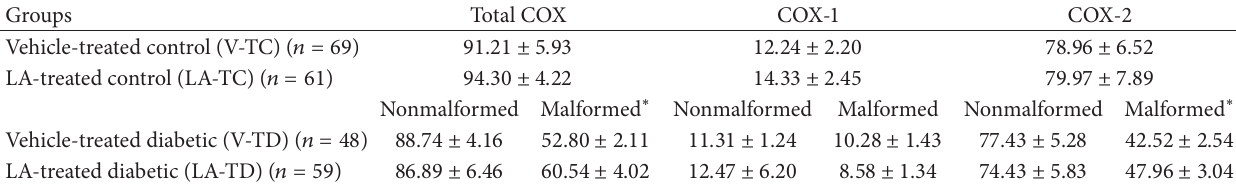
Table 5: COX activity in fetuses (U/mg of protein).